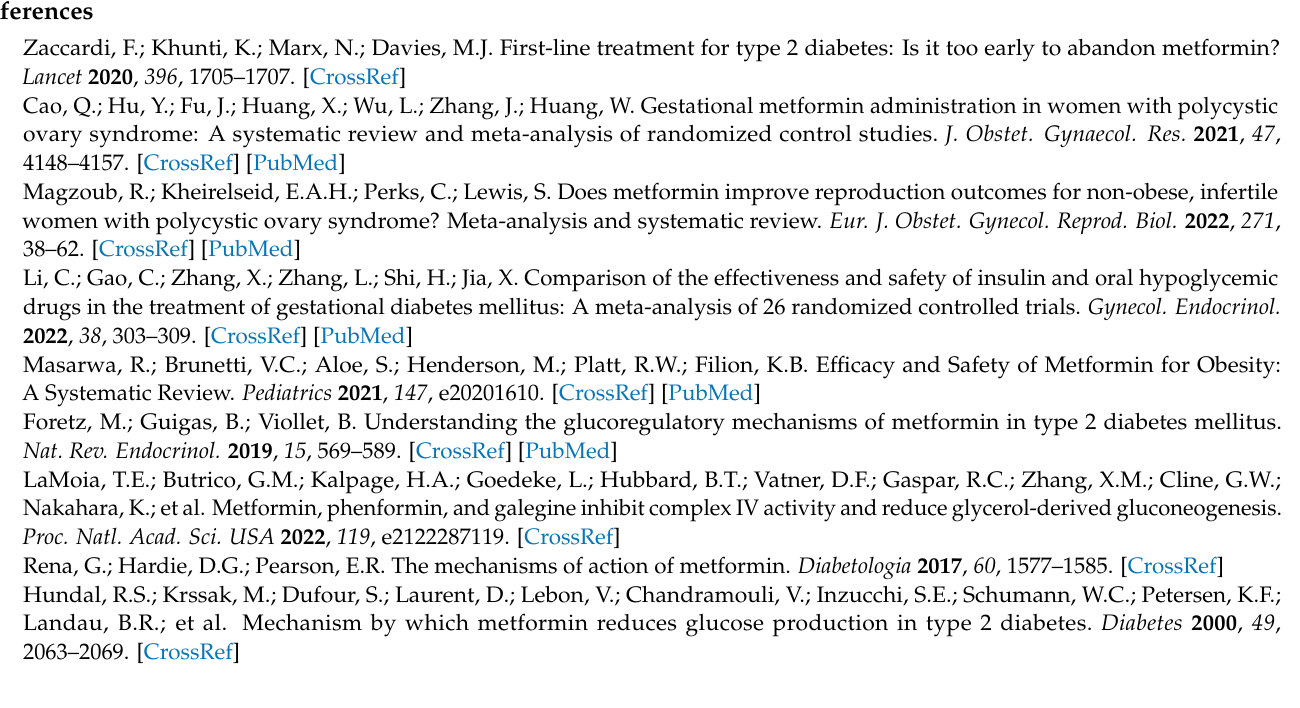
Figure S2: Pearson correlation map between number of upregulated and downregulated isoforms and other experiment characteristics; Figure S3: GAS5 genomic region with its transcripts from Ensembl genome Browser; Figure S4: LINC00511 genomic region with some of its transcripts from Ensembl Genome Browser; Figure S5: Predicted domains of EIF4G2-201 and EIF4G2-214; Table S1: Characteristics of the libraries used; Table S2: Differential Expression results for each series; Table S3: Correlation for all DETs; Table S4: Functional Enrichment for NEAT1-202 and AC016831.6-205 in each